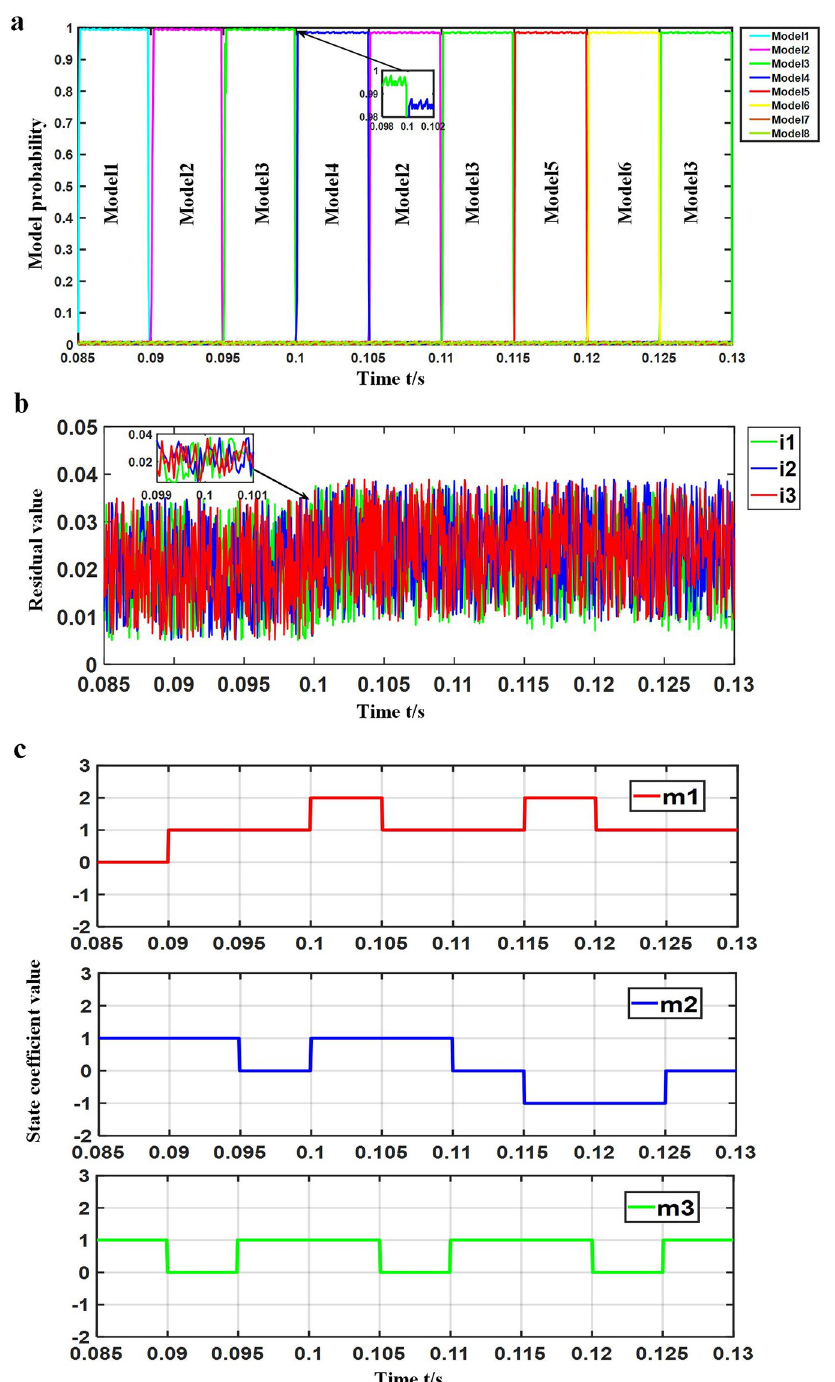
Fig 10. Simulation waveform of multiple faults occurring in sequence. (a) Probability change waveform of each model (b) Current residual waveform of each (c) Observation waveform of m 1 , m 2 and m 3 .